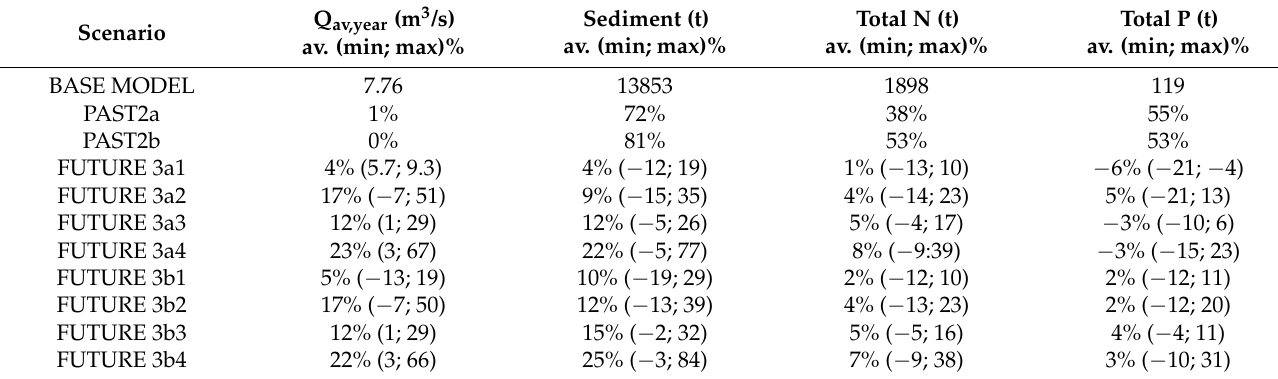
Table 5. Numerical modelling results for BASE MODEL, PAST and FUTURE